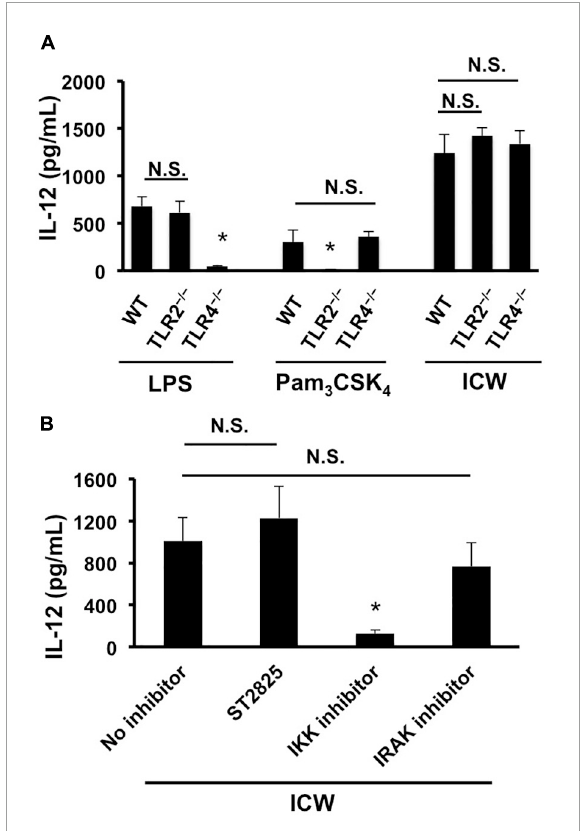
FIGURE6 Involvement of TLRs in IL-12 secretion from macrophages stimulated with ICWs. (A) BMMs were prepared from wild-type (WT), TLR2-deficient (TLR2 − / − ), and TLR4-deficient (TLR4 − / − ) mice, respectively. BMMs (5 × 10 4 /ml) were cultured with 1 µ g/ml of Pam 3 CSK 4 , 500 ng/ml of LPS, or 10 µ g/ml of ICWs for 24 h and IL-12 secreted in the culture supernatant was determined. Each bar is the mean ± SE for three independent experiments. N.S., not significant vs. BMMs from wild-type mice. * P < 0.01 vs. cells from wild-type mice. (B) BMMs prepared from wild-type mice were pretreated with 10 µ M of IKK inhibitor II, 10 µ M of ST2825, a MyD88 dimerization inhibitor and 0.5 µ M of IRAK1/4 inhibitor I, respectively, for 30 min, and then cells were stimulated with 10 µ g/ml of ICWs. After 24 h stimulation, IL-12 secreted in the culture supernatant was determined. Each bar is the mean ± SE for three independent experiments. N.S., not significant vs. cells treated without inhibitors (no